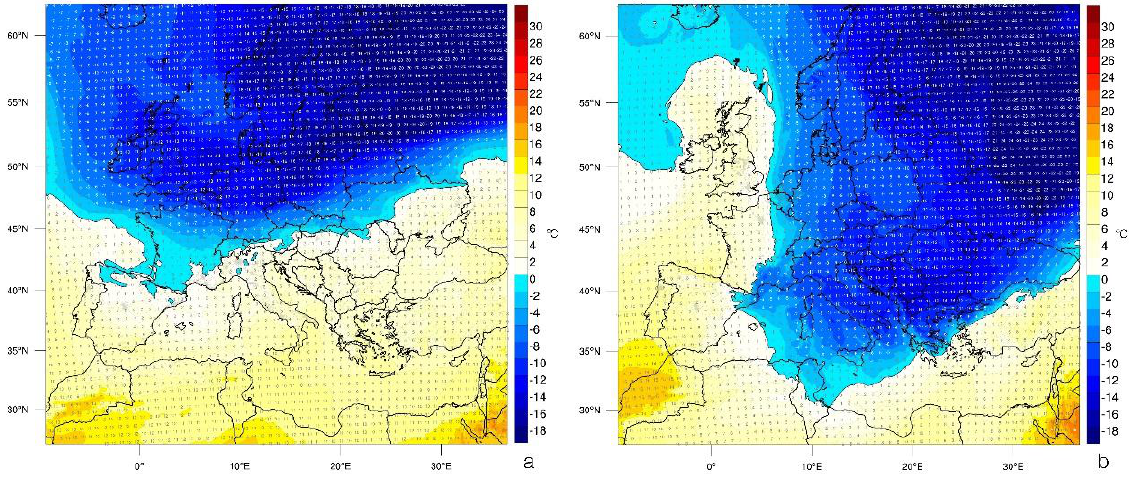
Figure 5. Forecast of 850 hPa temperature (at 2 K intervals) valid on: ( a ) 10 February 2021 at 1200 UTC, and ( b ) 14 February 1200 UTC based on BOLAM model initialized on 10 February 2021 at 0000 UTC.